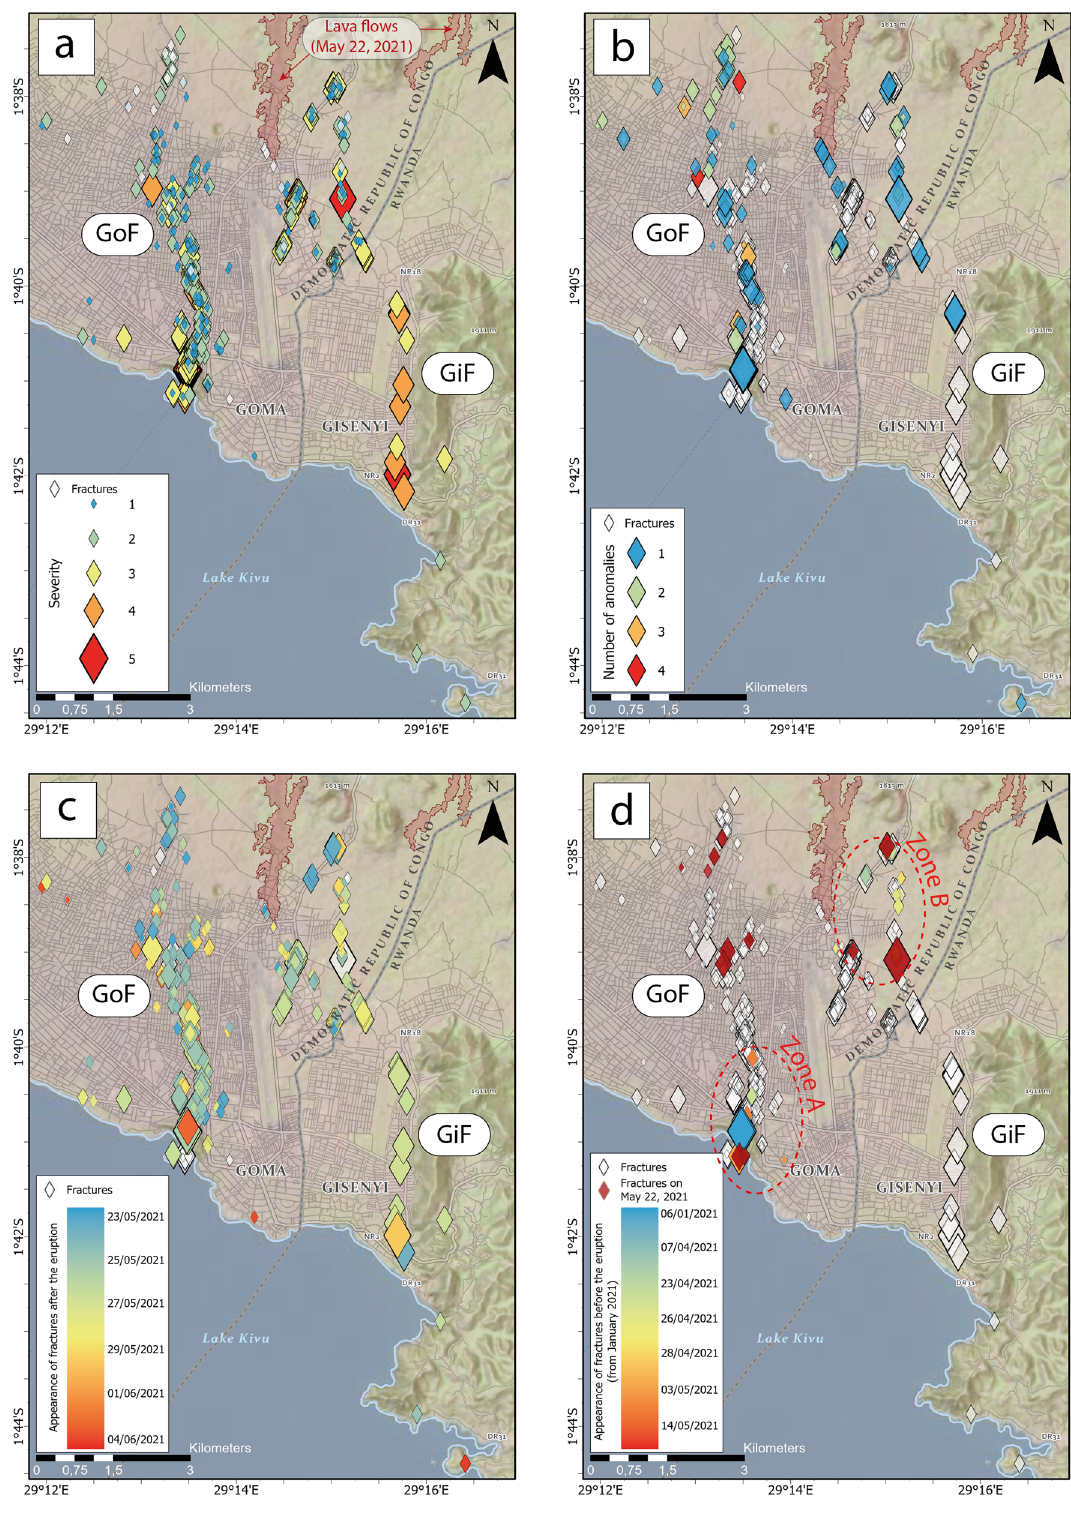
Figure 2. Maps produced from the results of the participatory system. ( a ) Location of the fractures classified by severity index. ( b ) Number of anomalies identified on fractures by the population of Goma and Gisenyi (uncoloured diamonds denote fractures without anomaly). Chronology of the appearance of fractures ( c ) after and ( d ) before the May 22, 2021 eruption. Credits Attribution: Esri, NASA, NGA, USGS; RMLUA, OpenStreetMap, HERE, Garmin,